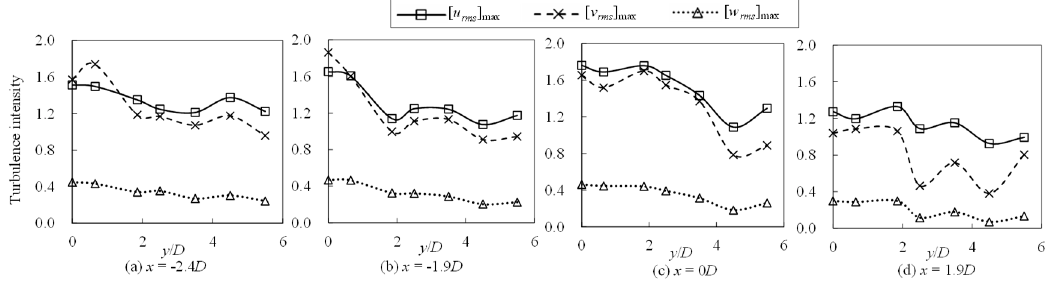
Figure 17. The extreme value of turbulence intensity varies with y / D .